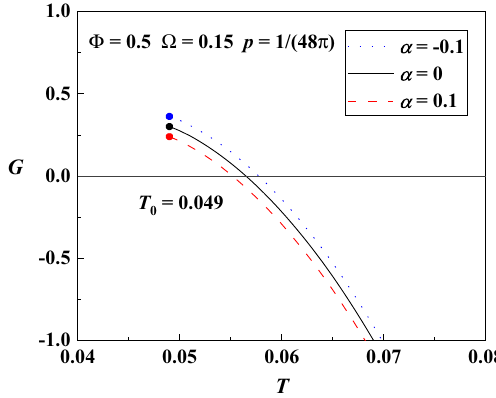
Fig. 12 The G – T curvesoftheKN–AdSblackholeswiththeGBterm, with Φ = 0 . 5, Ω = 0 . 15, and p = 1 /( 48 π) . T HP decreases with α , and all the curves start from the same minimal temperature T 0 = 0 .